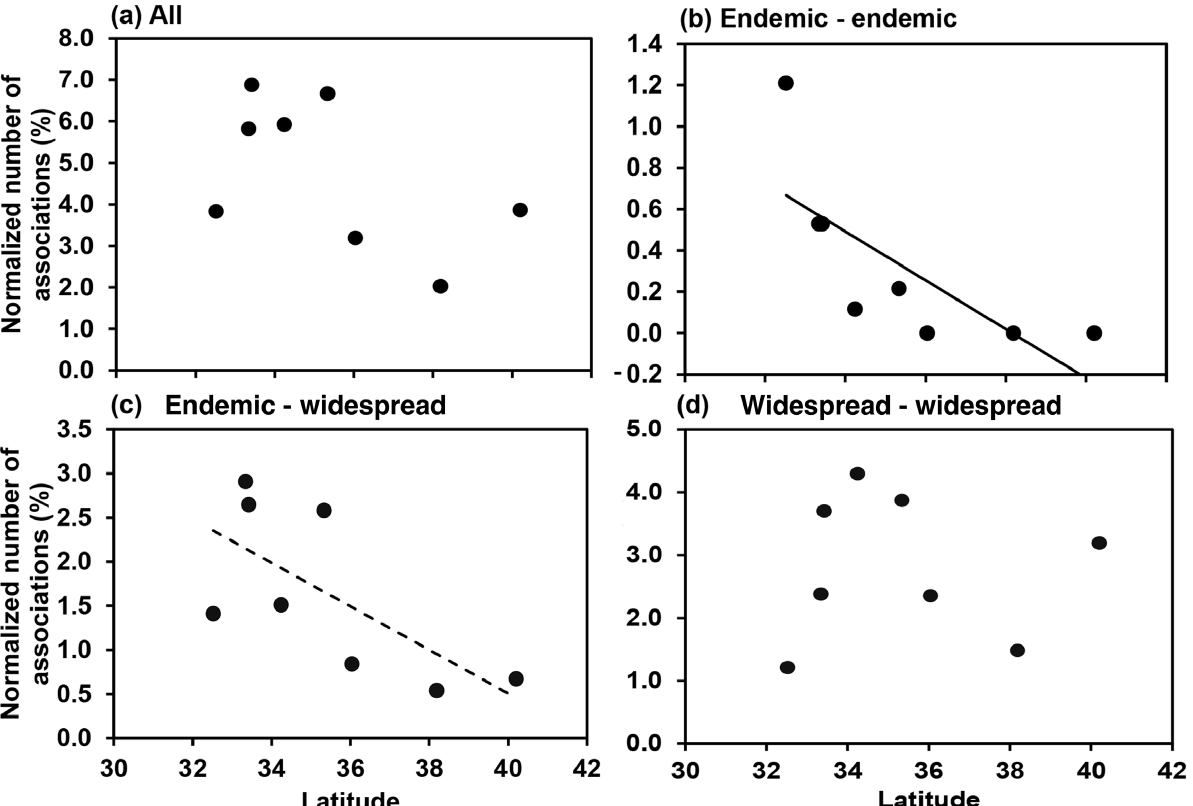
Figure 5. Number of species associations normalized by the number of possible associations by latitude: (a) all species associations, (b) associations between narrow-range endemic species, (c) associations between narrow-range endemic and widespread species, and (d) associations between widespread species. The number of associations decreased with increasing latitude when narrow-range endemic species were included (a, b, and c). When only widespread species were includes there was no relationship between latitude and species